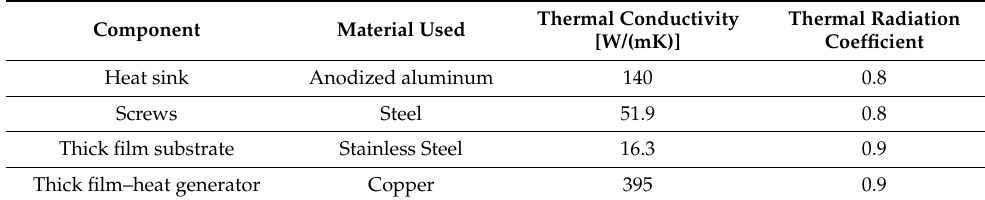
Table 3. Material definition used in simulations.